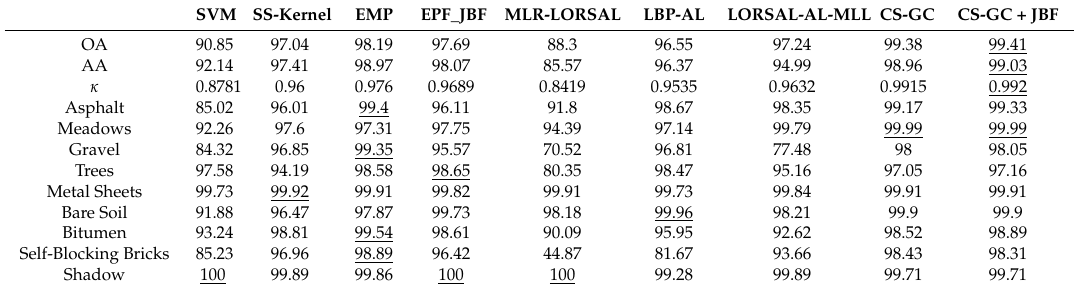
methods used in this work for comparison. The highest accuracies are indicated in underlined in each category.